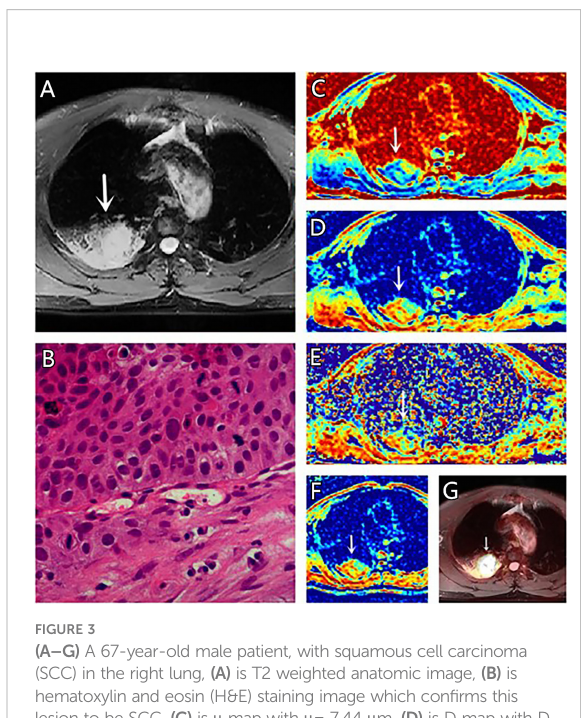
FIGURE 3 (A – G) A 67-year-old male patient, with squamous cell carcinoma (SCC) in the right lung, (A) is T2 weighted anatomic image, (B) is hematoxylin and eosin (H&E) staining image which con fi rms this lesion to be SCC, (C) is m map with m = 7.44 m m, (D) is D map with D = 1.42 m m 2 /ms, (E) is b map with b = 0.68, (F) is ADC map with ADC = 1.29 m m 2 /ms, (G) is the fusion image of the SUV map and the attenuation correction map with SUVmax = 18.75.